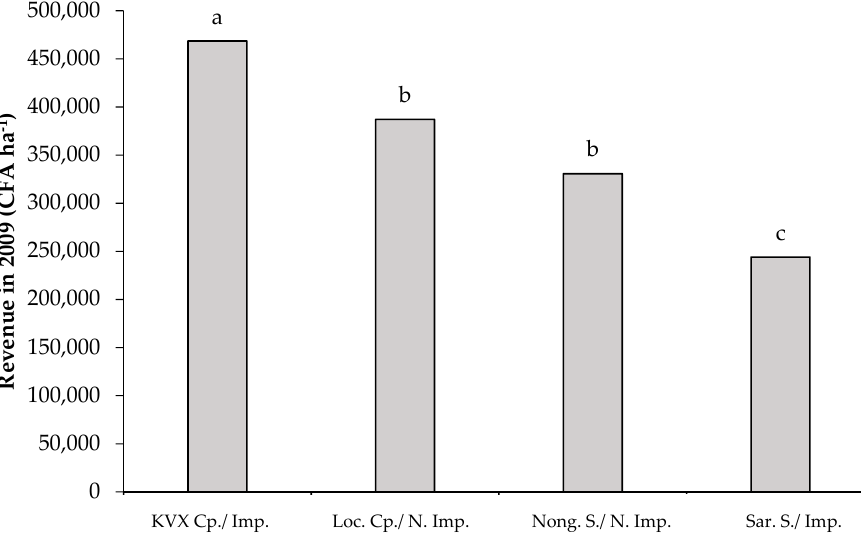
Figure 8. Mean revenue for cowpea or sorghum grain and stover in 2009. All plots were cropped in sorghum in 2008 and 2010. In 2009, for the crop rotation plots, a local cowpea variety was grown after Nongomsoba (local sorghum) while the improved cowpea variety KVX 396-4-4 was used after Sariaso 14 (improved sorghum). Abbreviations: KVX Cp.: KVX 396-4-4 Cowpea; Loc. Cp.: Local Cowpea; Nong. S.: Nongomsoba Sorghum; Sar. S.: Sariaso 14 Sorghum; Imp.: Improved; and N. Imp.: Nonimproved. Columns with the same letter are not significantly di ff erent at p < 0.05.